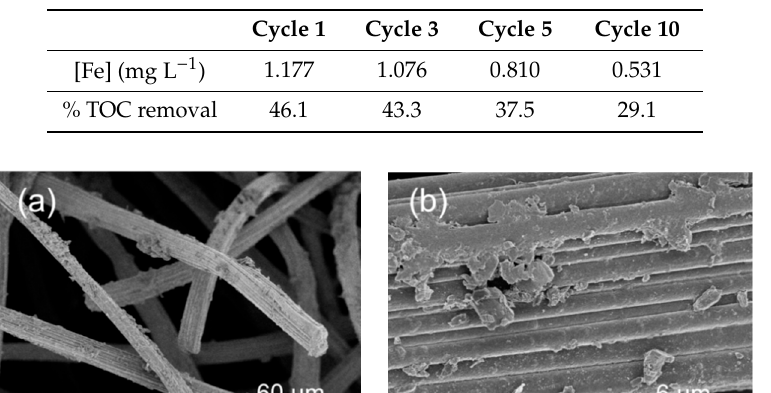
Table 2. Amount of Fe leaching in solution and percent TOC removal after 8 h heterogeneous electro-Fenton (EF) treatment using pC@CF800 / 5h cathode.